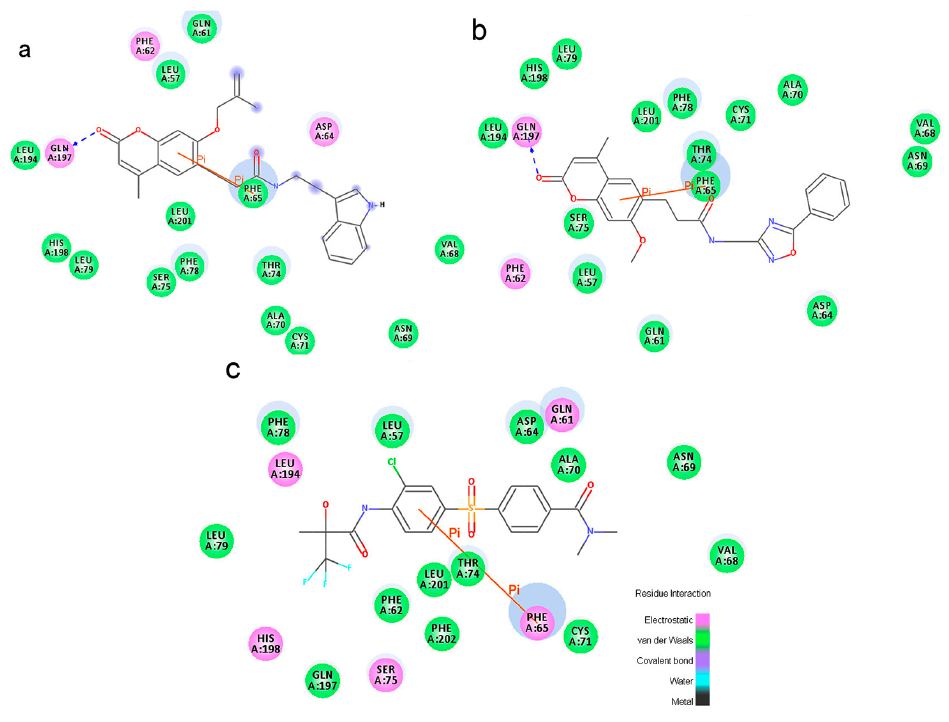
Figure 3. The inter-molecular interaction of the predicted binding modes of ( a ) ZINC12296427; ( b ) ZINC12389251 and ( c ) AZD7545 to PDK1. Table 5. Hydrogen bond interaction parameters for each compound and PDK residues. Receptor